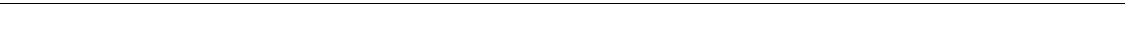
Figure 2. Perceived Contributors to Food and Housing Insecurity Among Students, Based on Workshops with Faculty and Staff